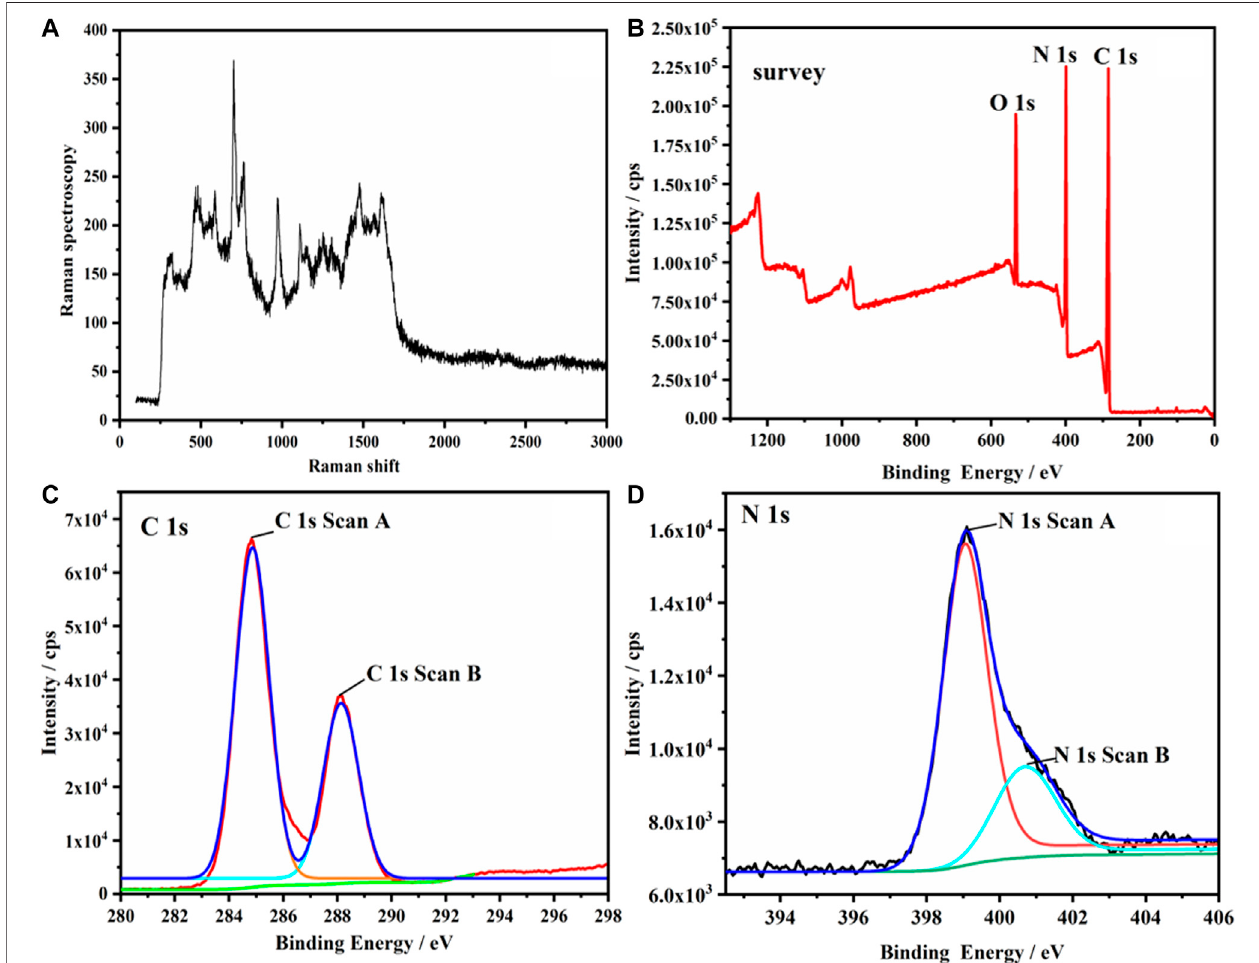
FIGURE 1 | (A) Raman spectra of g-C 3 N 4 , (B) XPS full spectrum of g-C 3 N 4 , (C) XPS C spectrum of g-C 3 N 4 , (D) XPS N spectrum of g-C 3 N 4 .